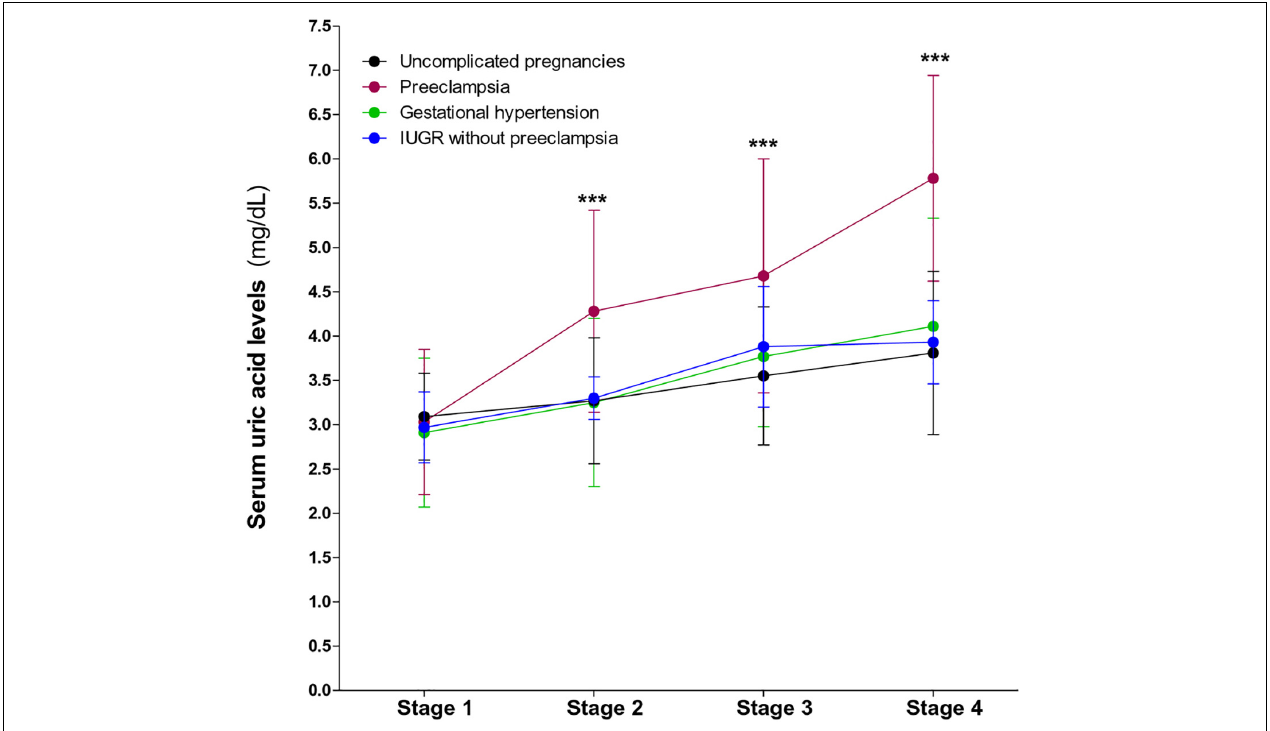
FIGURE 1 | Behavior of serum uric acid levels throughout gestation in preeclampsia, gestational hypertension, IUGR without preeclampsia, and in non-complicated pregnancies. A significant increase in uric acid levels is observed in preeclampsia. Values are mean ± SD. *** P < 0.001 preeclampsia vs. uncomplicated pregnancies.